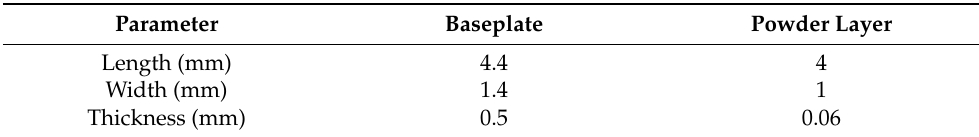
Figure 3. The model geometry and the computational domain (the mesh) were used in the study. Table 2. Model dimensions.